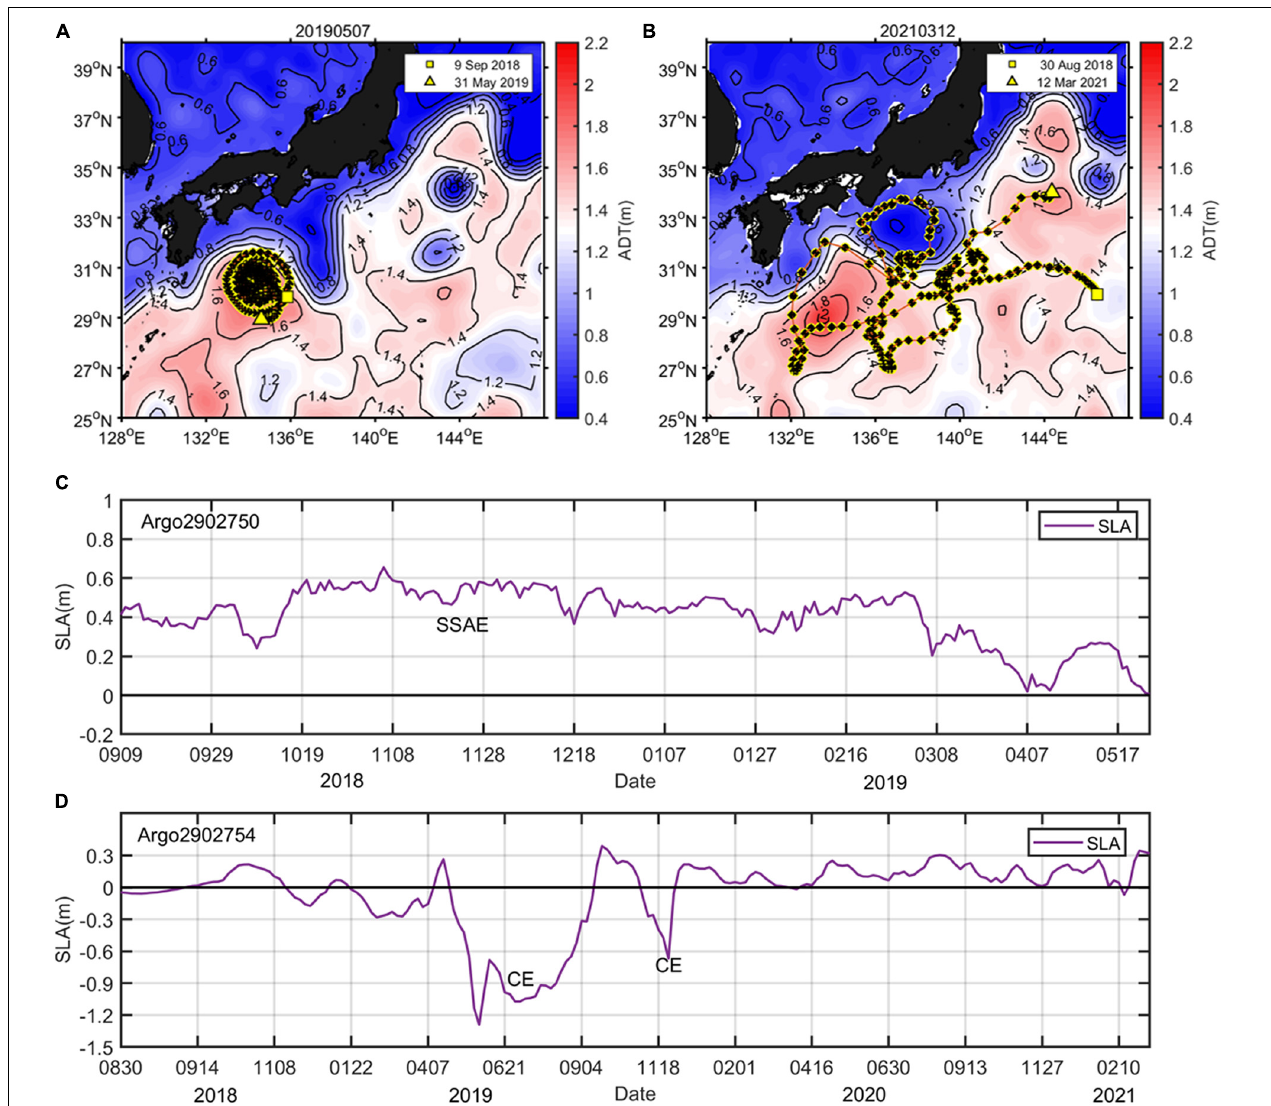
FIGURE 2 | Tracks and the simultaneous time series of SLA of the BGC-Argo 2902750 (A,C) and BGC-Argo 2902754 (B,D) deployed in the Northwest Pacific. The background represents the absolute dynamic topography (ADT; contour and color, units: m) on the specific day of observation. The location of the first and last profiling of the floats is marked by squares and triangles,